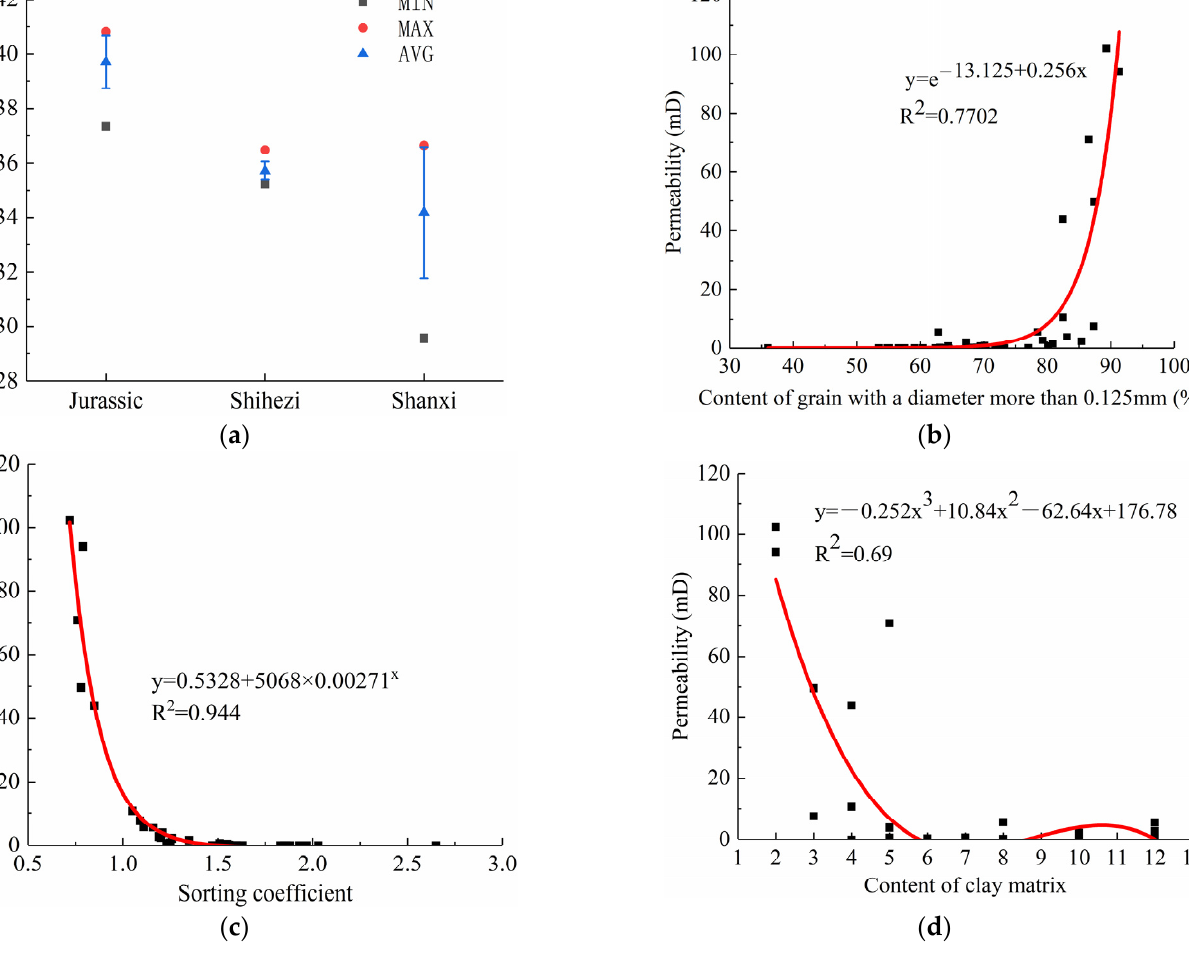
Figure 8. The effects of sedimentation on the pore structure and permeability of the deep-mine sandstone: ( a ) Initial porosity comparisons of the three layers of sandstone. ( b ) Correlation between the permeability and the content of grains larger than 0.125 mm. ( c ) The correlation between the permeability and sorting coefficient. ( d ) The correlation between the permeability and clay matrix contents.